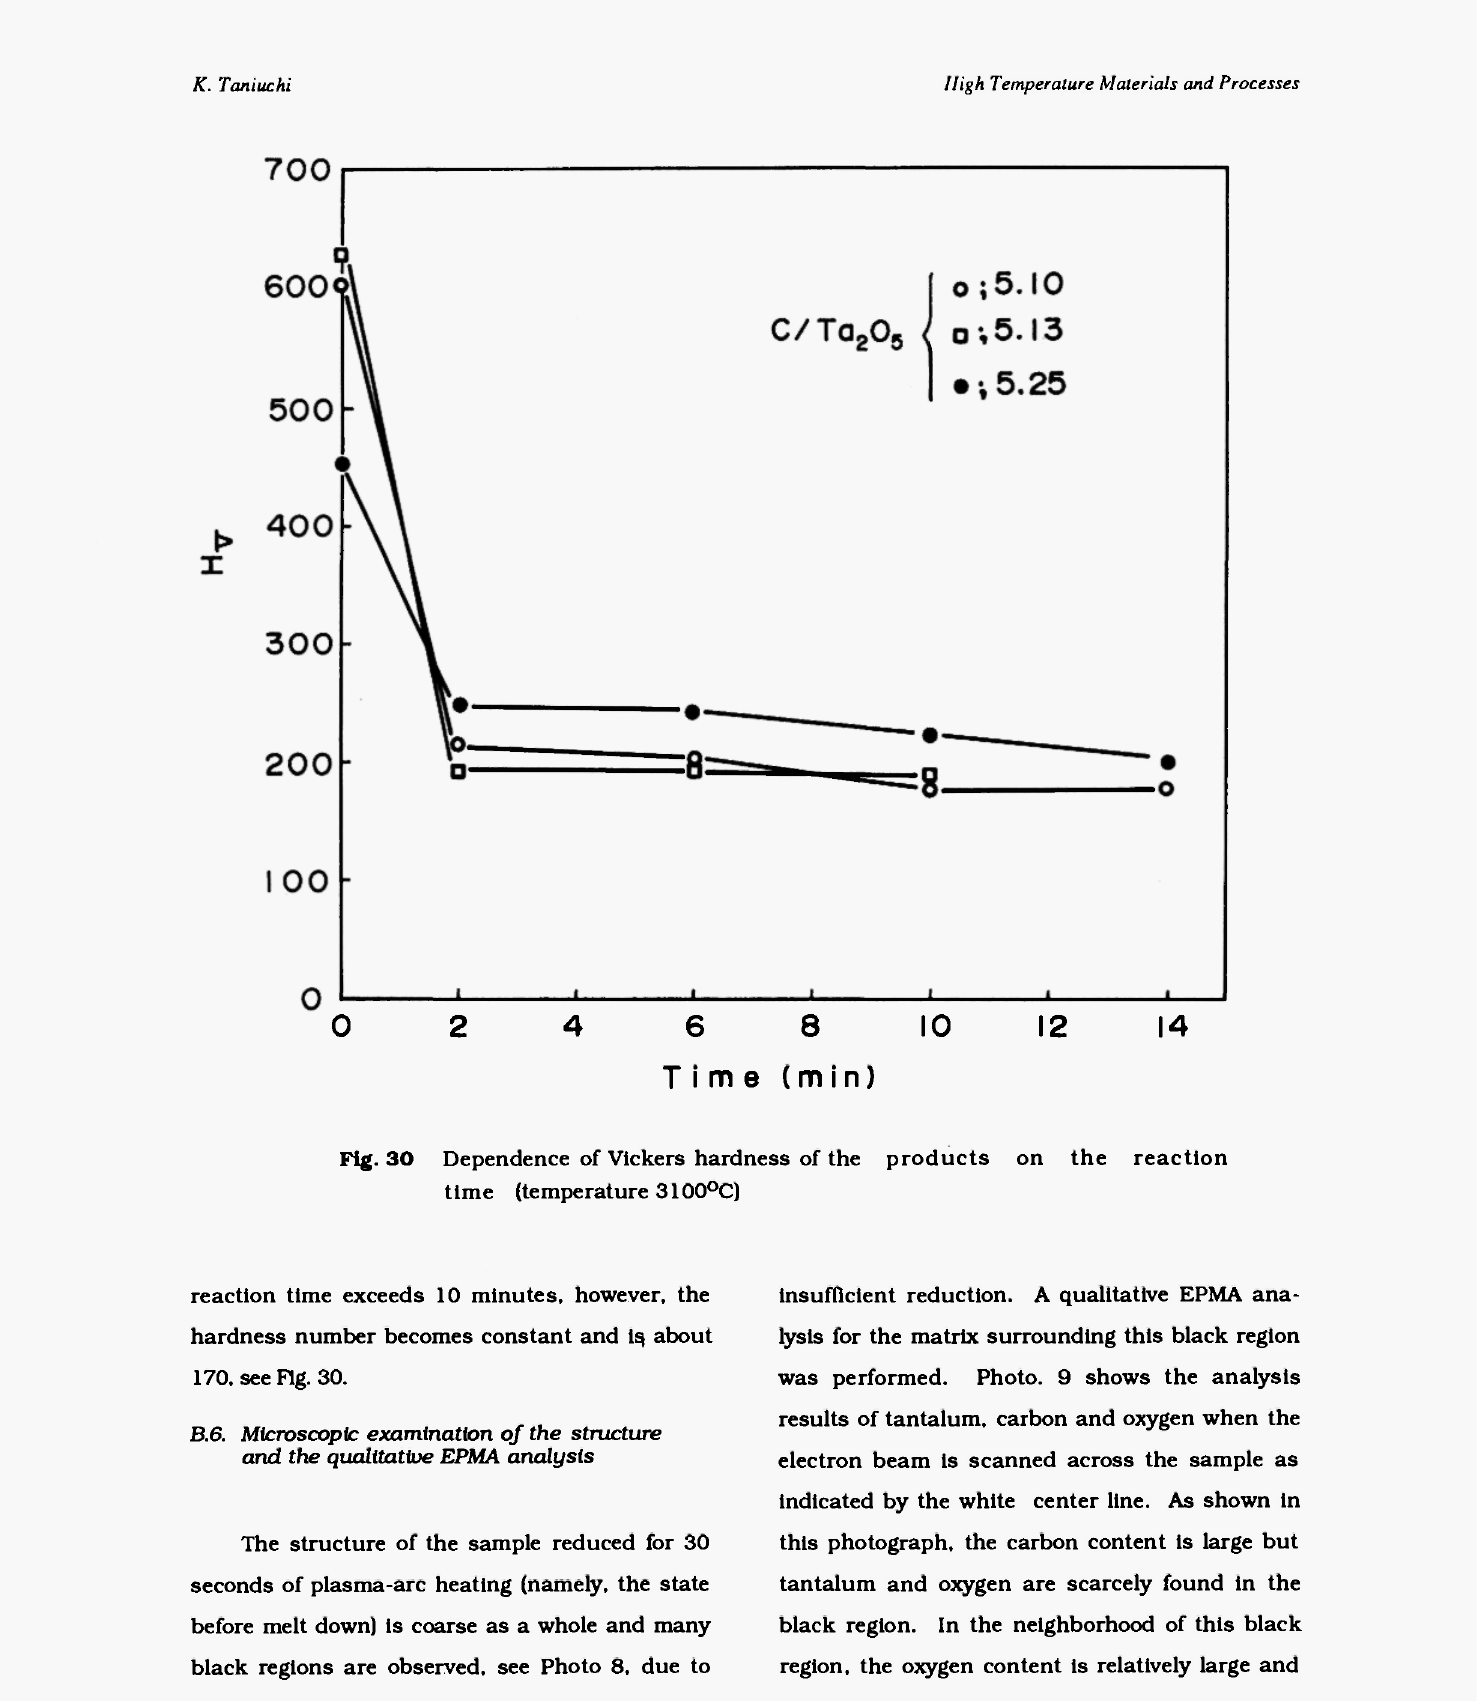
Fig. 30 Dependence of Vickers hardness of the products on the reaction time (temperature